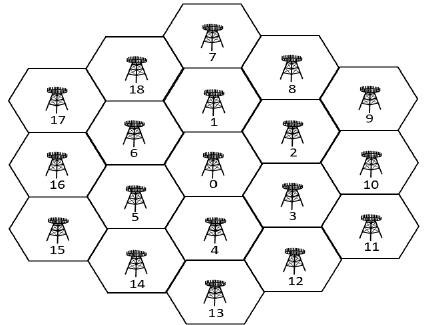
Figure 3. Simulation topology.